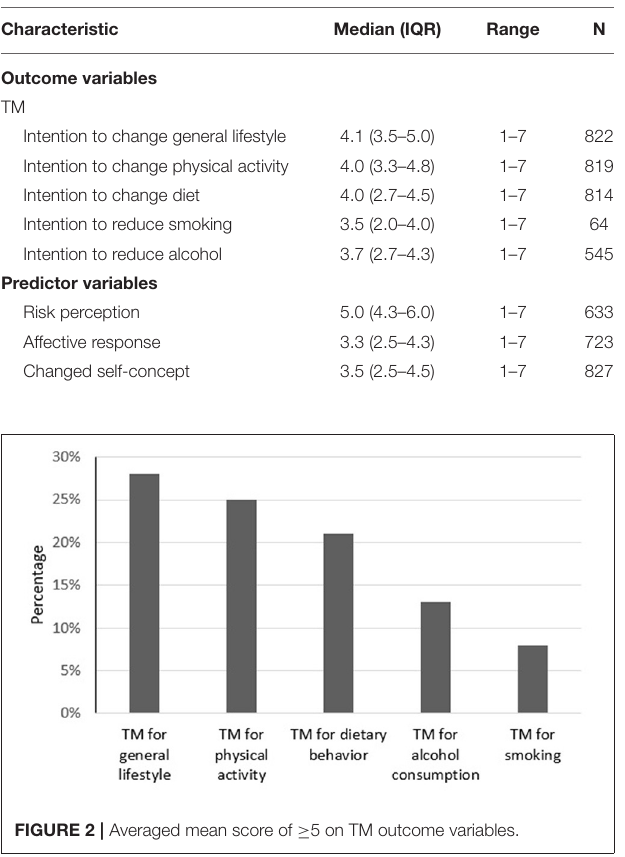
TABLE 2 | Median (IQR) and range of TM outcome variables and predictors.